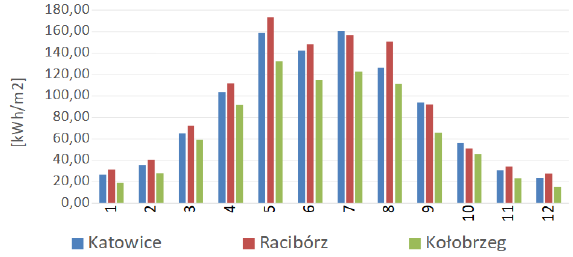
Fig. 2. Radiation magnitude for investigated regions (numbers at X axis represent months)